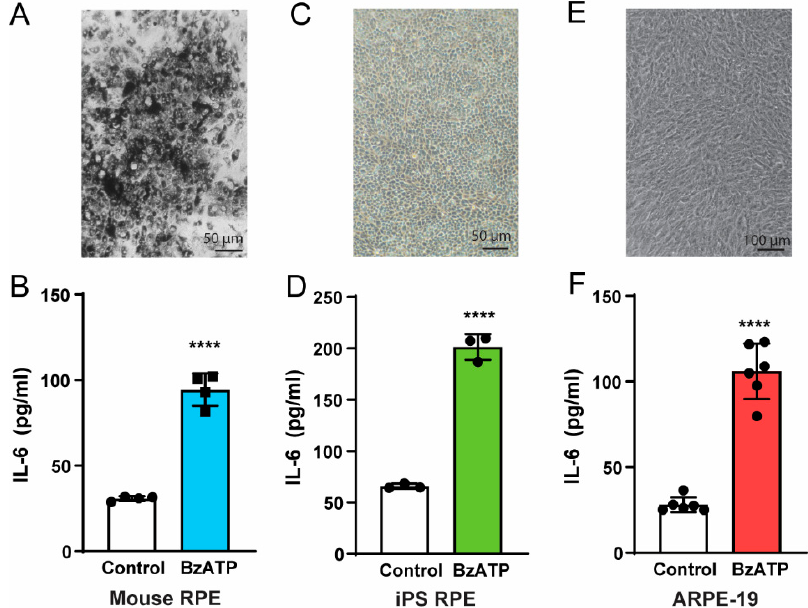
Figure 1. BzATP triggers IL-6 release from mouse, iPS-derived RPE cells and ARPE-19 cells.